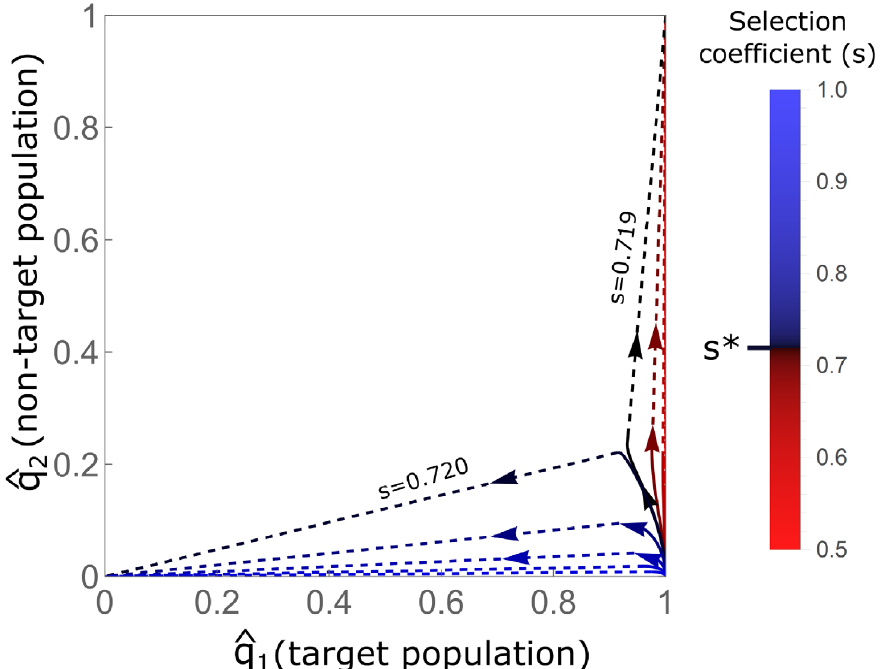
Fig 4. Trajectories of DTEs with increasing migration rates. Shown are trajectories for DTEs for gene drives with full conversion ( c = 1; h values are not relevant in this case since there are no heterozygotes) and different selection coefficients ( s ), marked in different colors. Arrows show the direction of increased migration; solid lines show the increase of migration below m � , and dashed lines show the abrupt transition of the equilibrium state when m � is exceeded, to either global fixation (1, 1) or global loss (0, 0). The color bars for s are centered such that the selection coefficient that maximizes m � , s � � 0.72, is shown in black, selection coefficients below s � are in red, and those above s � are in blue. s � forms the threshold between convergence to global fixation and convergence to global loss when the threshold m � is exceeded.